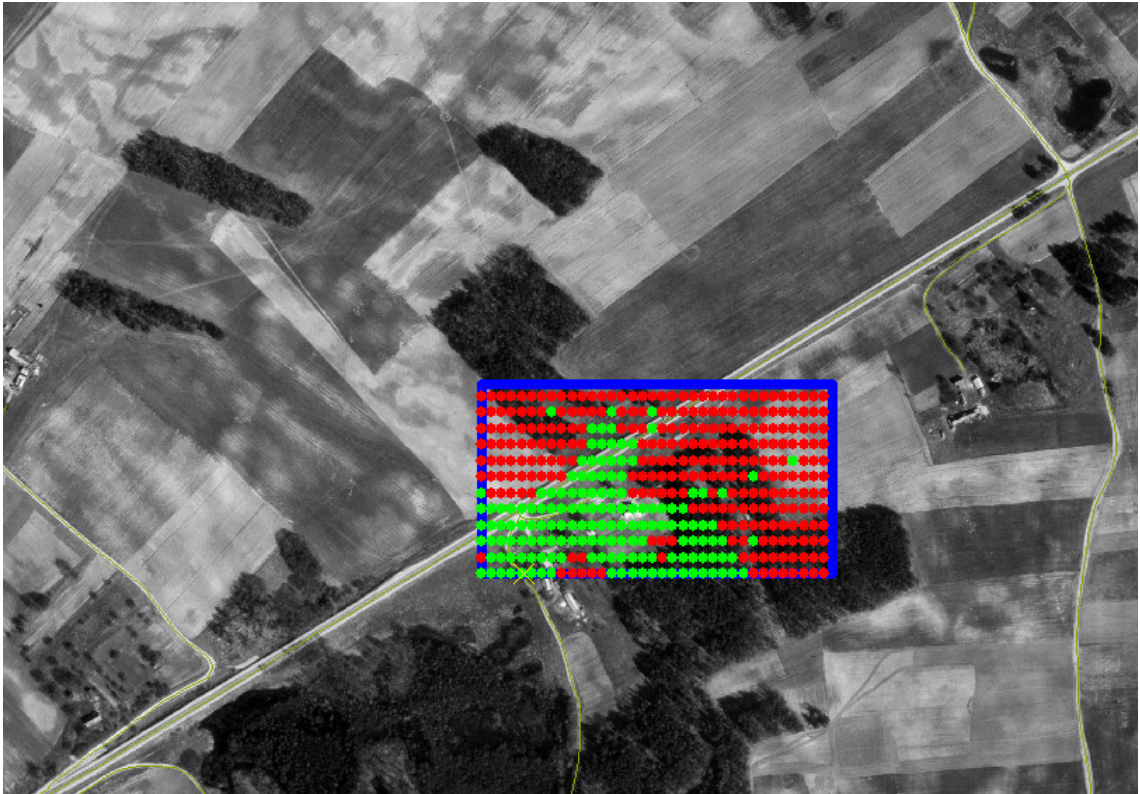
Fig 3. Battlefield squares ( ≈ 10x10 m.) singled out for analysis Table. Matrix of the